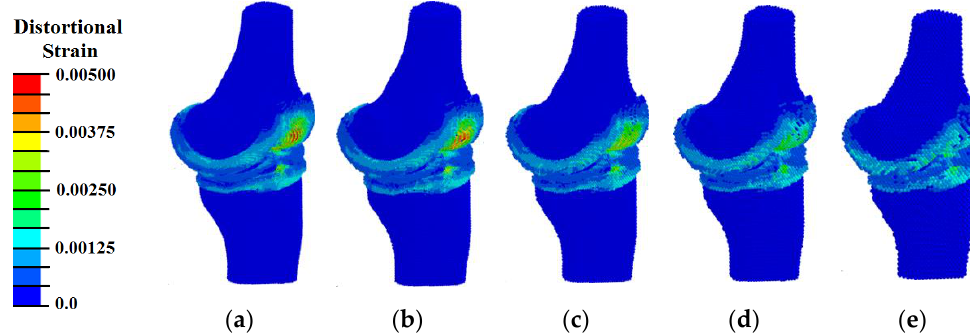
Figure 4. Distributions of distortional strain in the samples with different diameter of elements: ( a ) 0.75 mm; ( b ) 1.0 mm; ( c ) 1.3 mm; ( d ) 1.5 mm; ( e ) 2.0 mm.